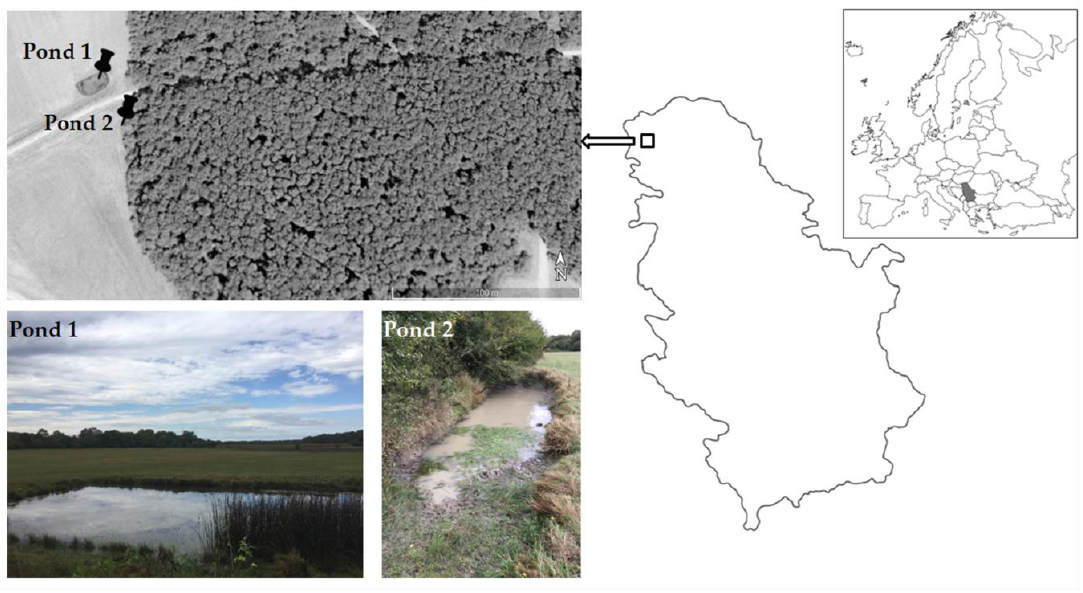
Figure 4. Study area and sampling localities.